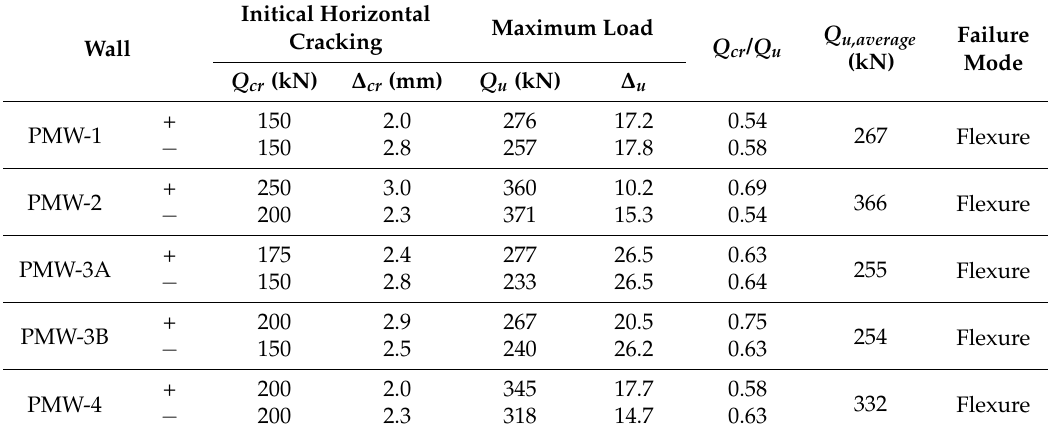
Table 2. Summary of test results.